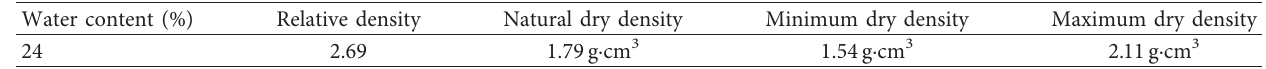
Table 1: Basic physical parameters of gravelly